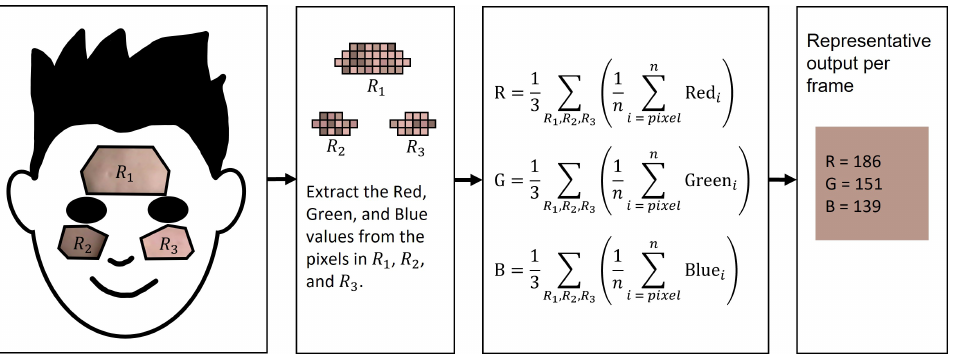
Figure 1. Graphical abstract of the pipeline from a frame to the R, G, and B values. The process repeats for each frame from the 1-min video resulting in the three time series: R ( t ) , G ( t ) , and B ( t ) . i = pixel, n = number of pixels in ROI, R 1 , R 2 , R 3 = Regions of interests.